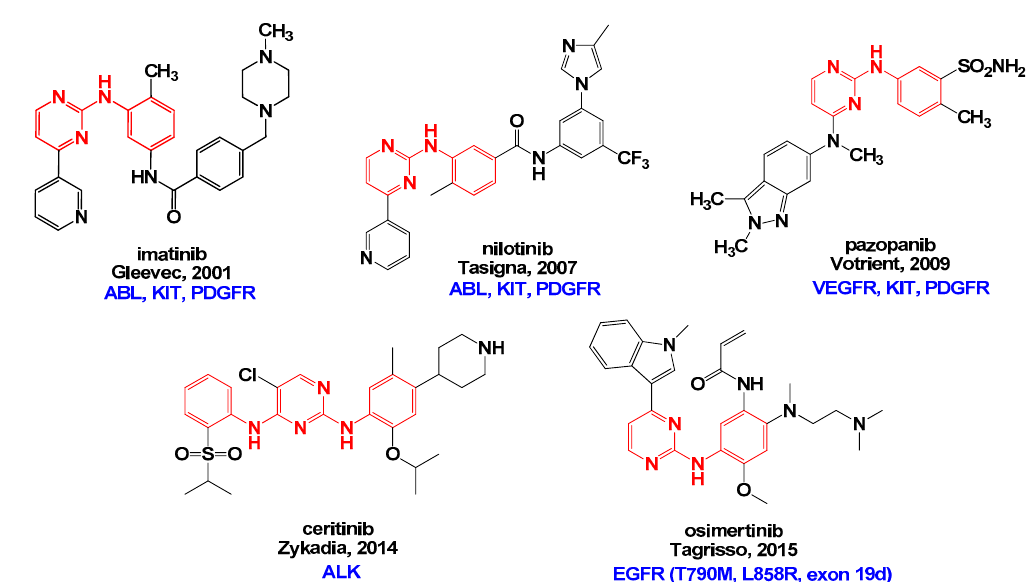
Figure 1. FDA-approved kinase inhibitors containing phenylaminopyrimidine (PAP). The PAP fragments are colored red. INN, brand name, year FDA approved, and main target kinases are provided for each kinase drug. Kinase abbreviations: ABL: Abelson kinase; KIT: stem cell factor receptor; PDGFR: platelet derived growth factor receptor; VEGFR: vascular endothelial growth factor receptor; ALK: anaplastic lymphoma kinase; EGFR: epidermal growth factor receptor.